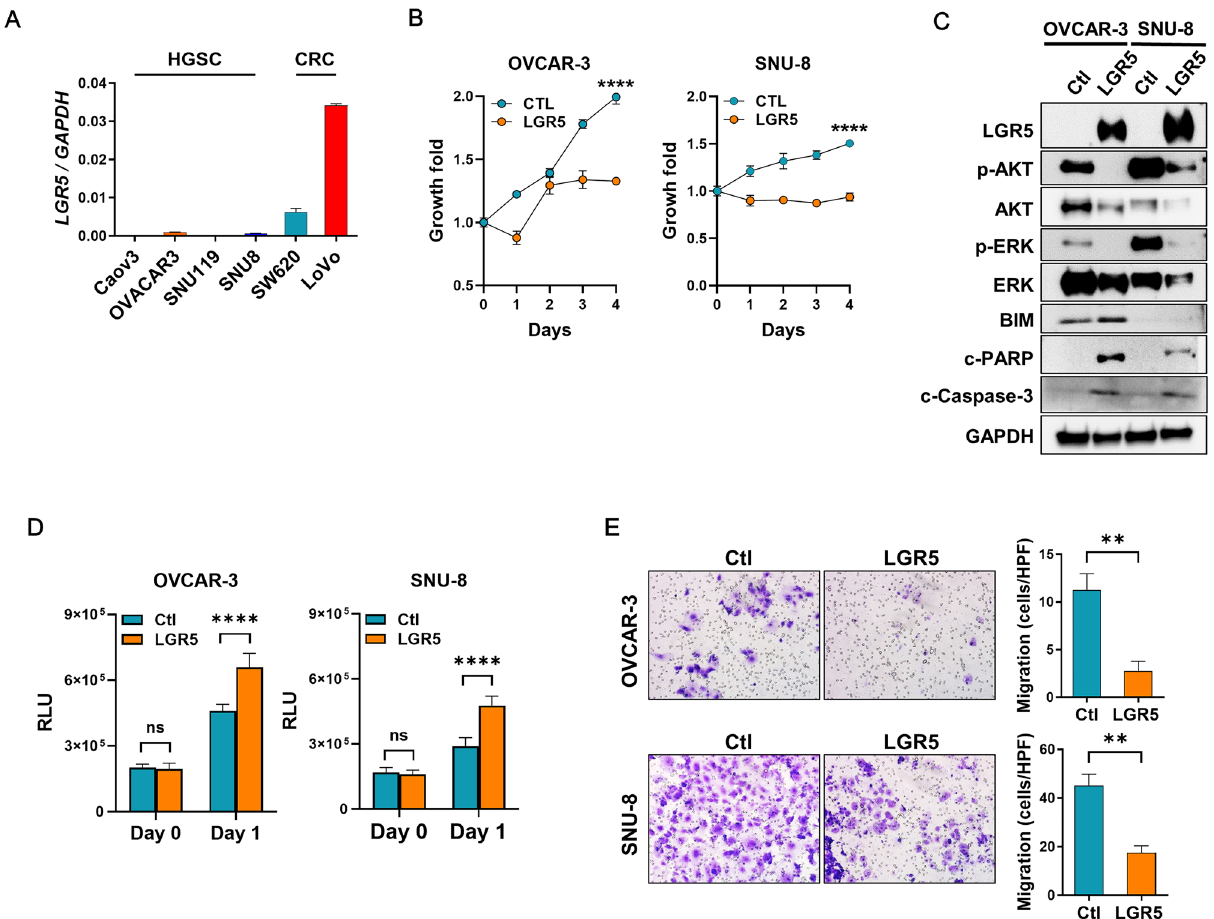
Figure 7. The suppressive effects of LGR5 on high-grade serous carcinoma (HGSC) cell growth and migration. ( A ) Real-time PCR was performed to measure the mRNA levels of LGR5 in four human HGSC cell lines compared to colorectal cancer (CRC) cell lines, SW620 and LoVo. ( B ) OVAR-3 and SNU-8 cells were transfected with a control or a LGR5-expressing plasmid. Cell growth was measured using a Cell Counting Kit-8 at the indicated times. ( C ) Twenty-four h after transfection with a control or a LGR5-expressing plasmid in OVCAR-3 and SNU-8 cells, an immunoblot assay for survival and apoptosis-related proteins was performed using the antibodies indicated in the figure. ( D ) Caspase-3 activity was measured after transfecting cells with a control or a LGR5-expressing plasmid. ( E ) The effect of LGR5 expression on the migration activity of OVCAR-3 and SNU-8 cells was evaluated using a transwell migration assay. Cellular migration was imaged at 0 and 48 h. c-PARP cleaved PARP; c-caspase-3 cleaved caspase-3; Ctl control; RLU relative light unit. Data are presented as the mean ± SD. ** P < 0.01, **** P < 0.0001 by unpaired t